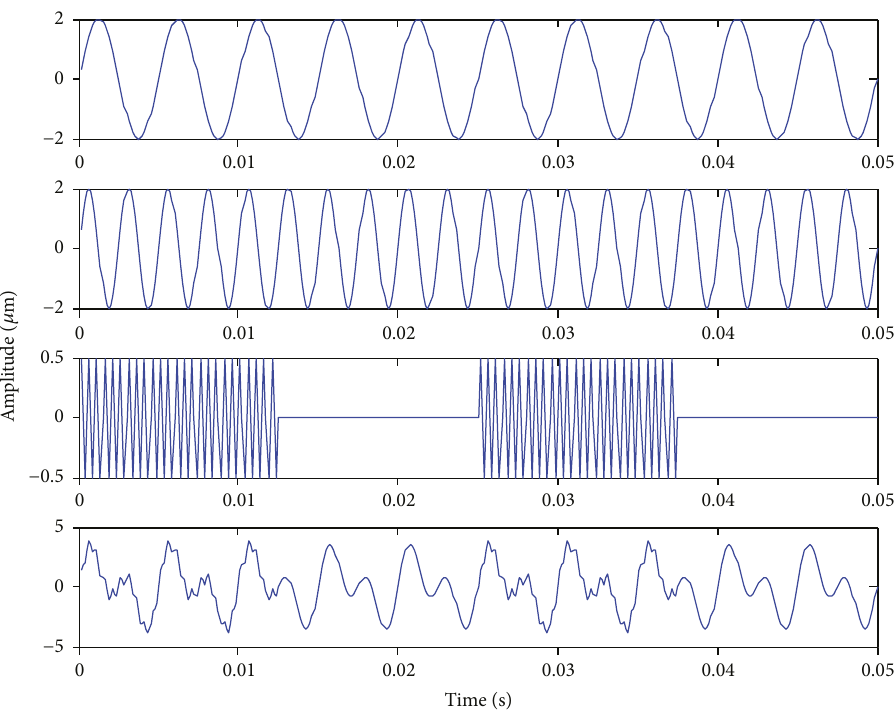
Figure 2: Simulation signal.